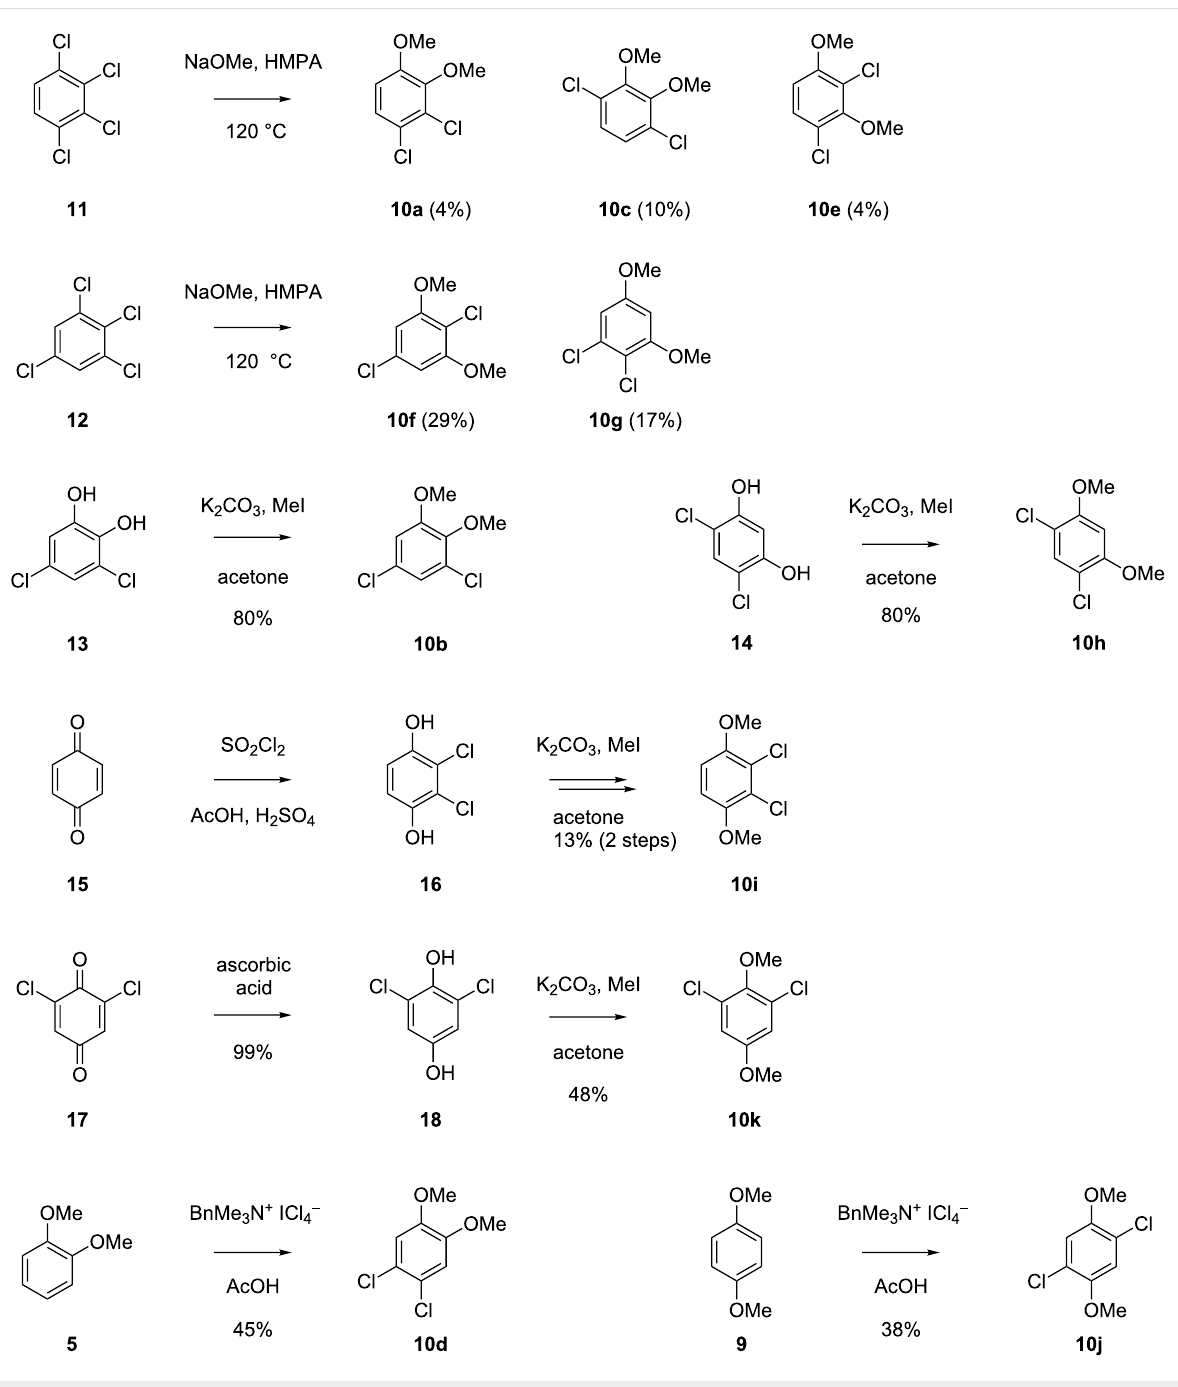
(Figure 5) [26]. The biological function of 4b and 10b